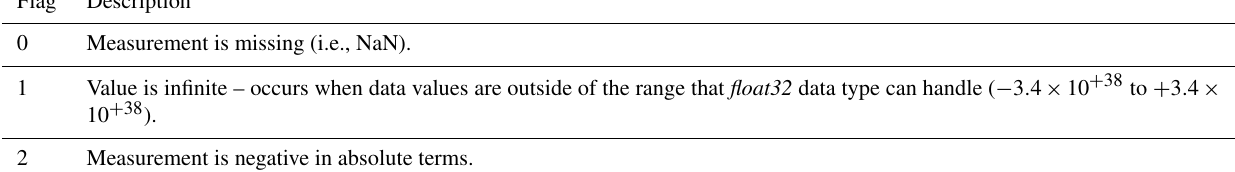
Table D1. Description of the GHOST quality assurance flags used on the EEA air quality observational